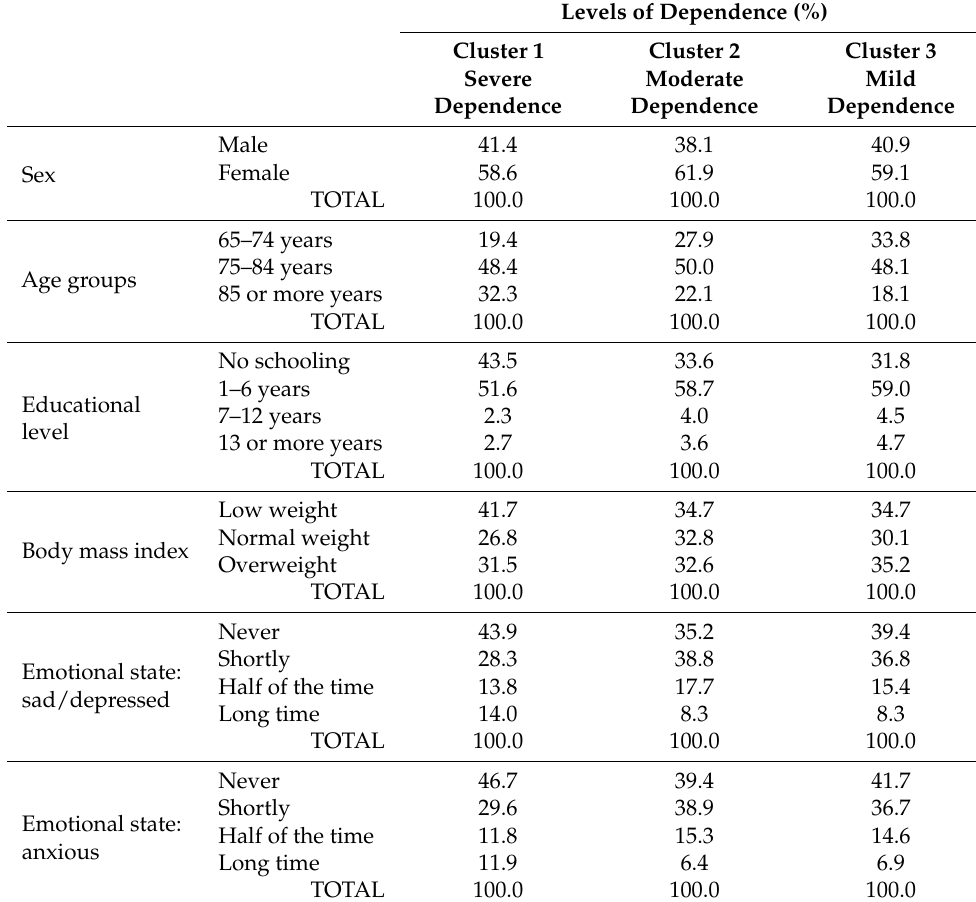
Table 2. Characterization of the people aged 65 years or older in the Long Term Care and Maintenance Units by sex, age groups, educational level, body mass index, emotional state: sad/depressed and emotional state: anxious, within each